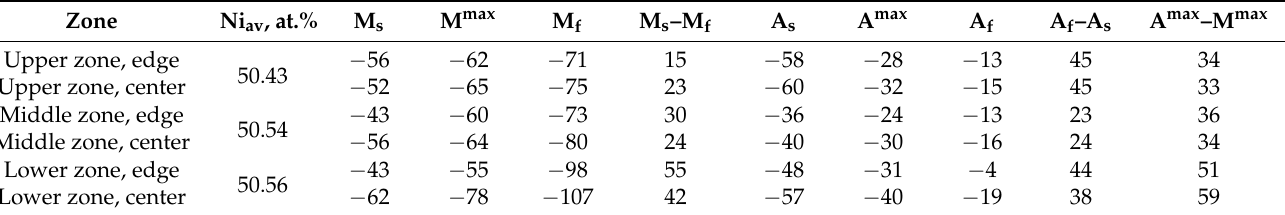
Table 1. DSC results for 3 zones of the specimen, °C.